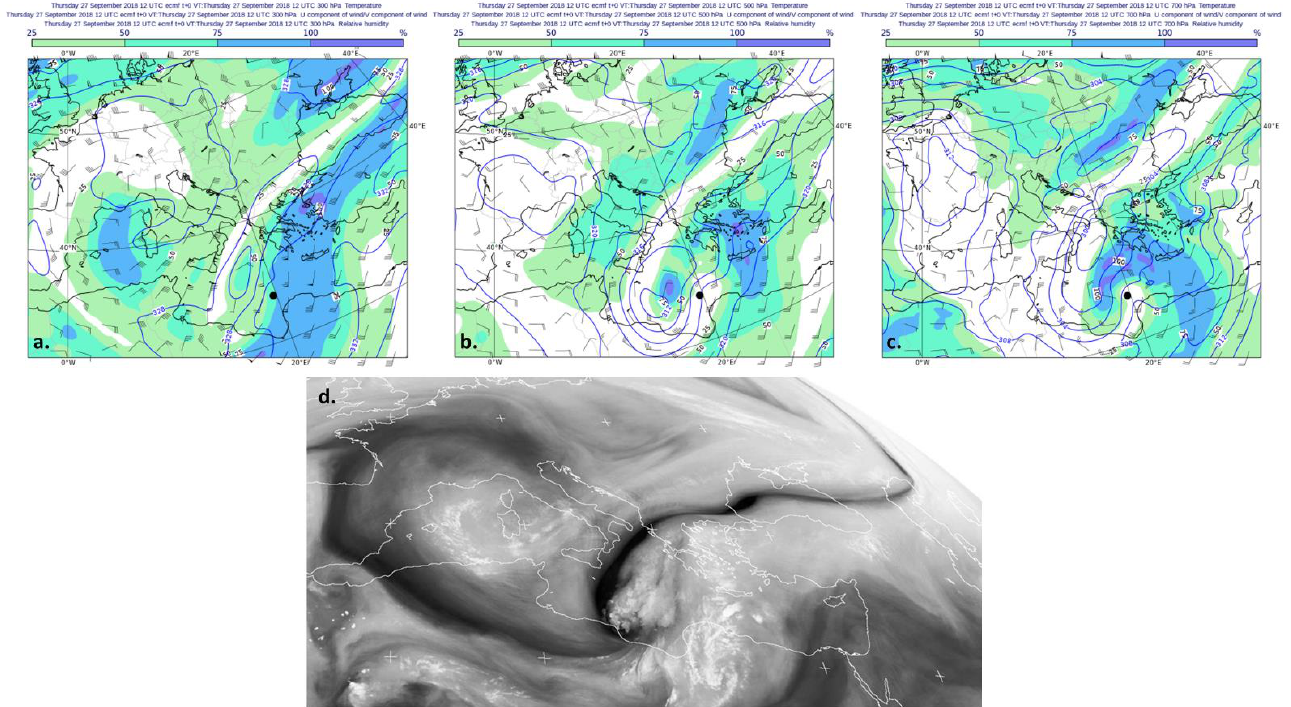
Figure 14. Potential temperature (continuous lines; in K), relative humidity (coloured contours; in %) and winds for 27/12 UTC at ( a ) 300 hPa, ( b ) 500 hPa, ( c ) 700 hPa, and ( d ) water vapor MSG (6.2 µ m, channel 5) satellite image at 27/12 UTC. Black dot on the maps indicates the location of the system centre.